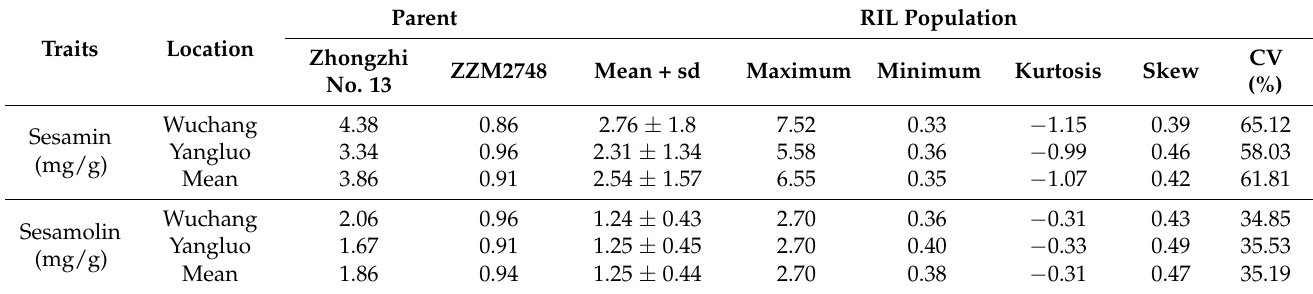
Table 1. Phenotypes of sesamin and sesamolin in RIL families and parental lines.